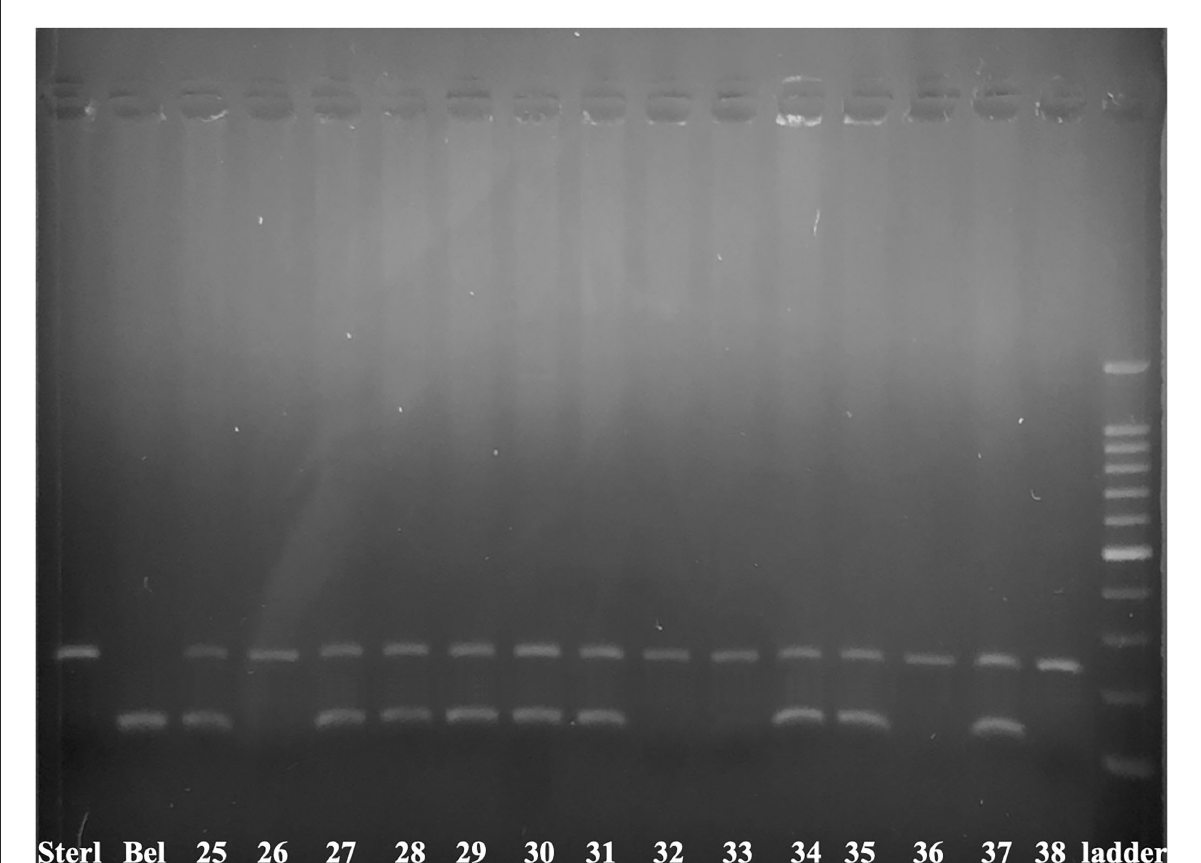
FIGURE3 Electrophoretogram of 153_HH and 247_AR markers in 14 produced embryos. The marker 247_AR amplifies 247 bp band only when the sample contains nuclear DNA of sterlet, while the marker 153_HH amplifies the 153 bp band only when the sample contains nuclear DNA of beluga. Sterlet fin (Sterl) and beluga fin (Bel) are positive controls. The numbers 25–33, 35–38 are corresponding to transplants after ICSI of single non-activated cryopreserved beluga spermatozoa into sterlet’s eggs. Number 34 is a control embryo produced after in vitro fertilization of cryopreserved beluga spermatozoa with sterlet eggs 100–1500 bp